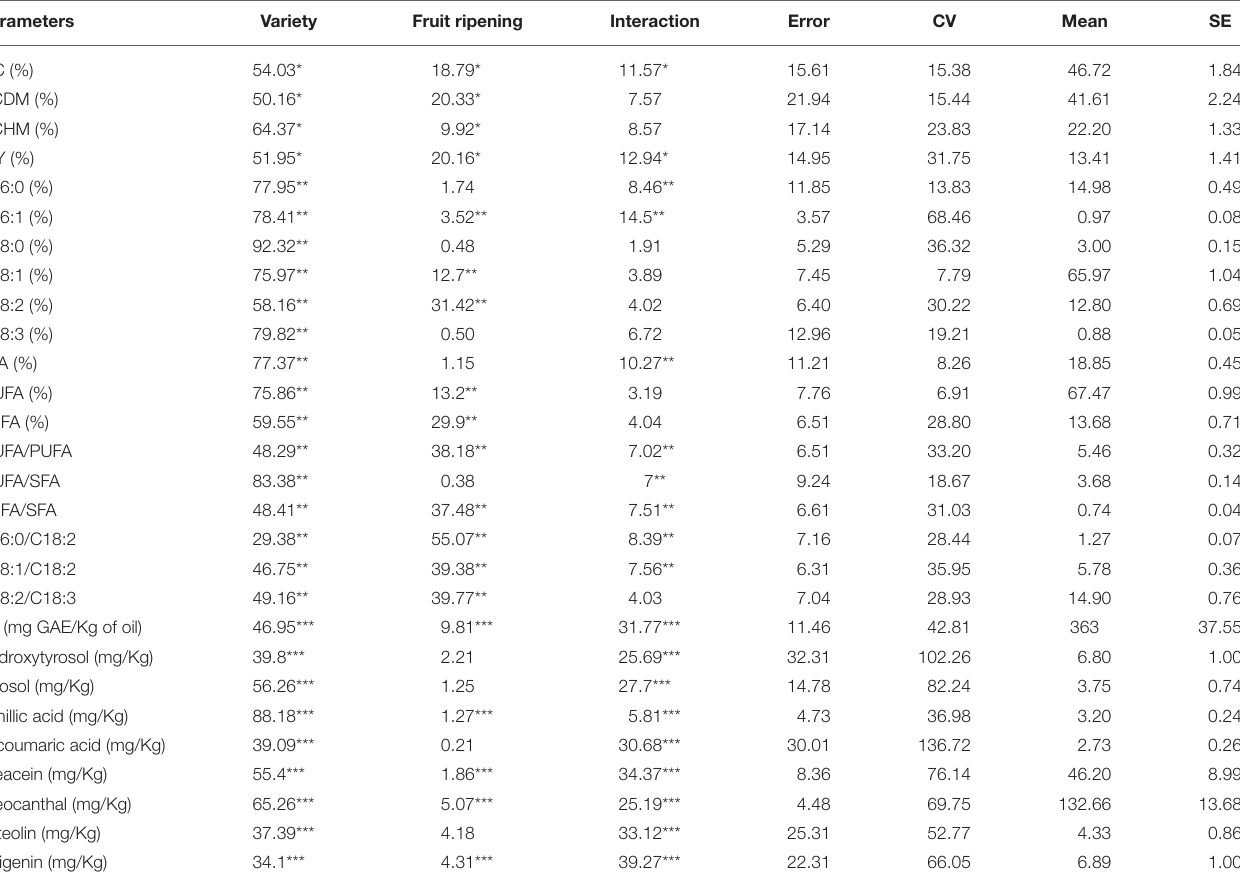
TABLE 2 | Relative importance of varieties and ripening index expressed as percentages of total sum of squares and significance in the ANOVA for different traits under study. Parameters Variety Fruit ripening Interaction Error CV